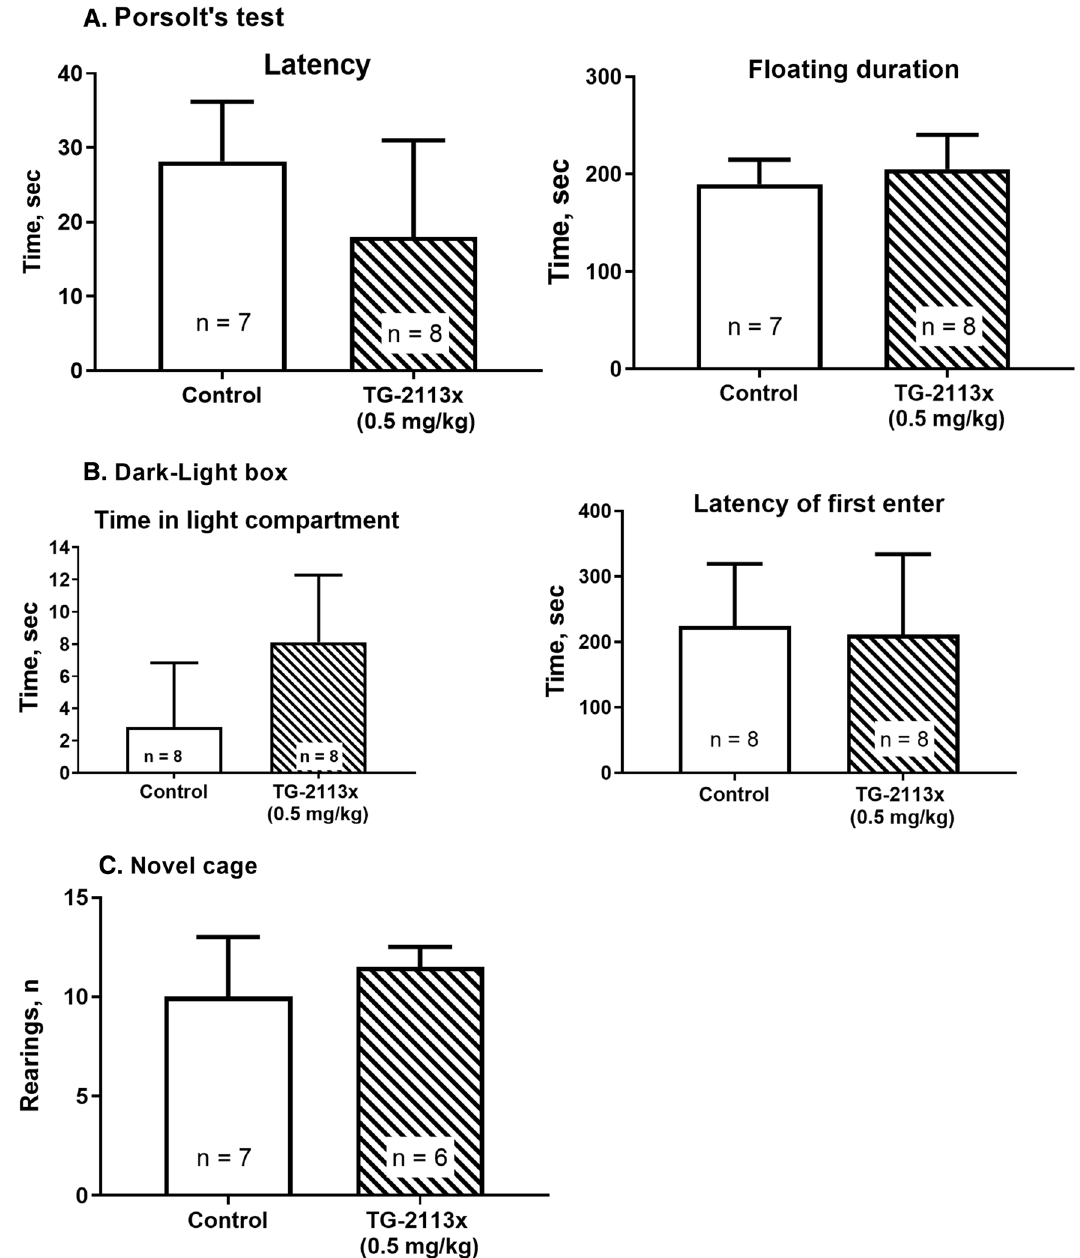
Figure 8. Tg-2113x does not affect the depressive-like ( A ), anxiety-like ( B ) and exploratory ( C ) behavior of young (3 mounths-old)